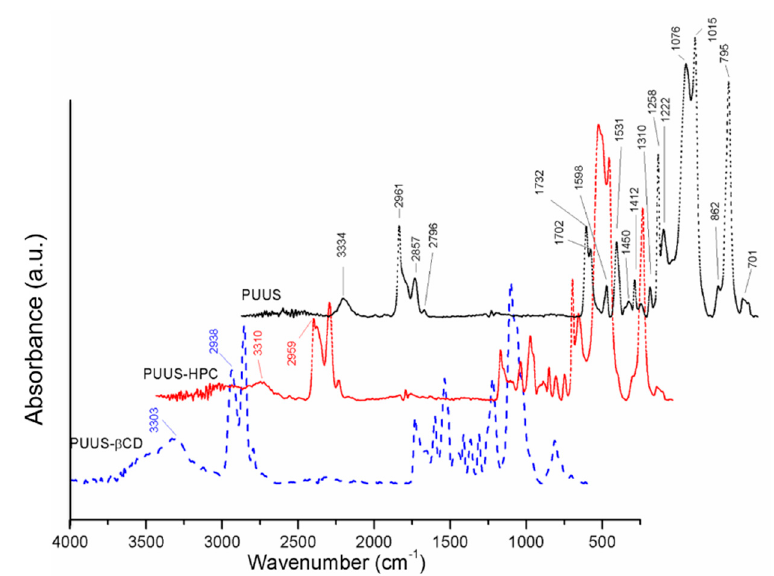
Figure 2. FTIR-ATR spectra of nanofibrous mat (polyurethane urea siloxane (PUUS)) and nanofibrous composite mats (PUUS-hydroxypropyl cellulose (HPC) and PUUS- β -cyclodextrin ( β CD)).